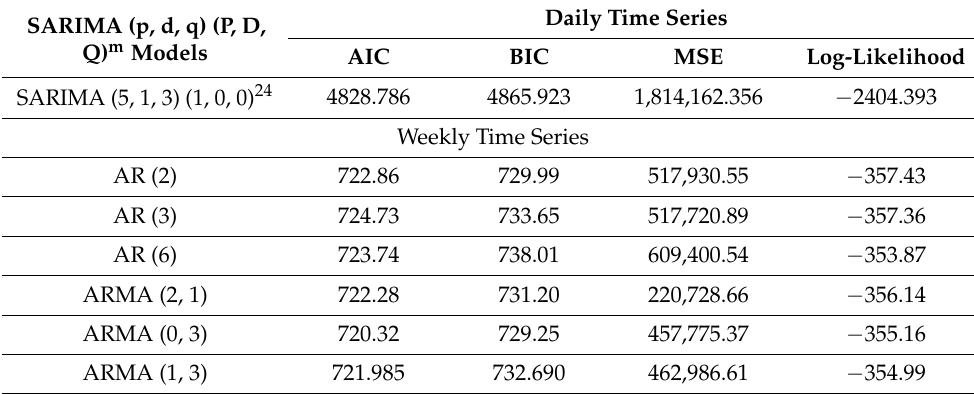
Table 4. Performance evaluation of different models for Box–Jenkins. SARIMA (p, d, q) (P,